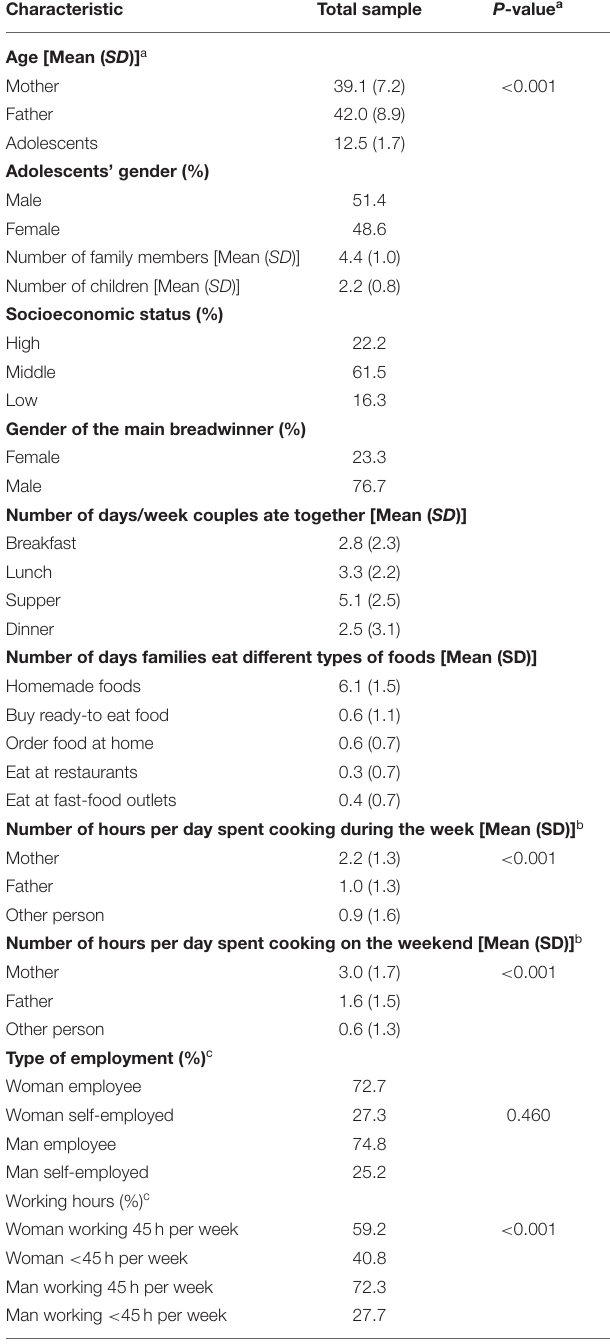
TABLE 1 | Sample characteristics ( n =